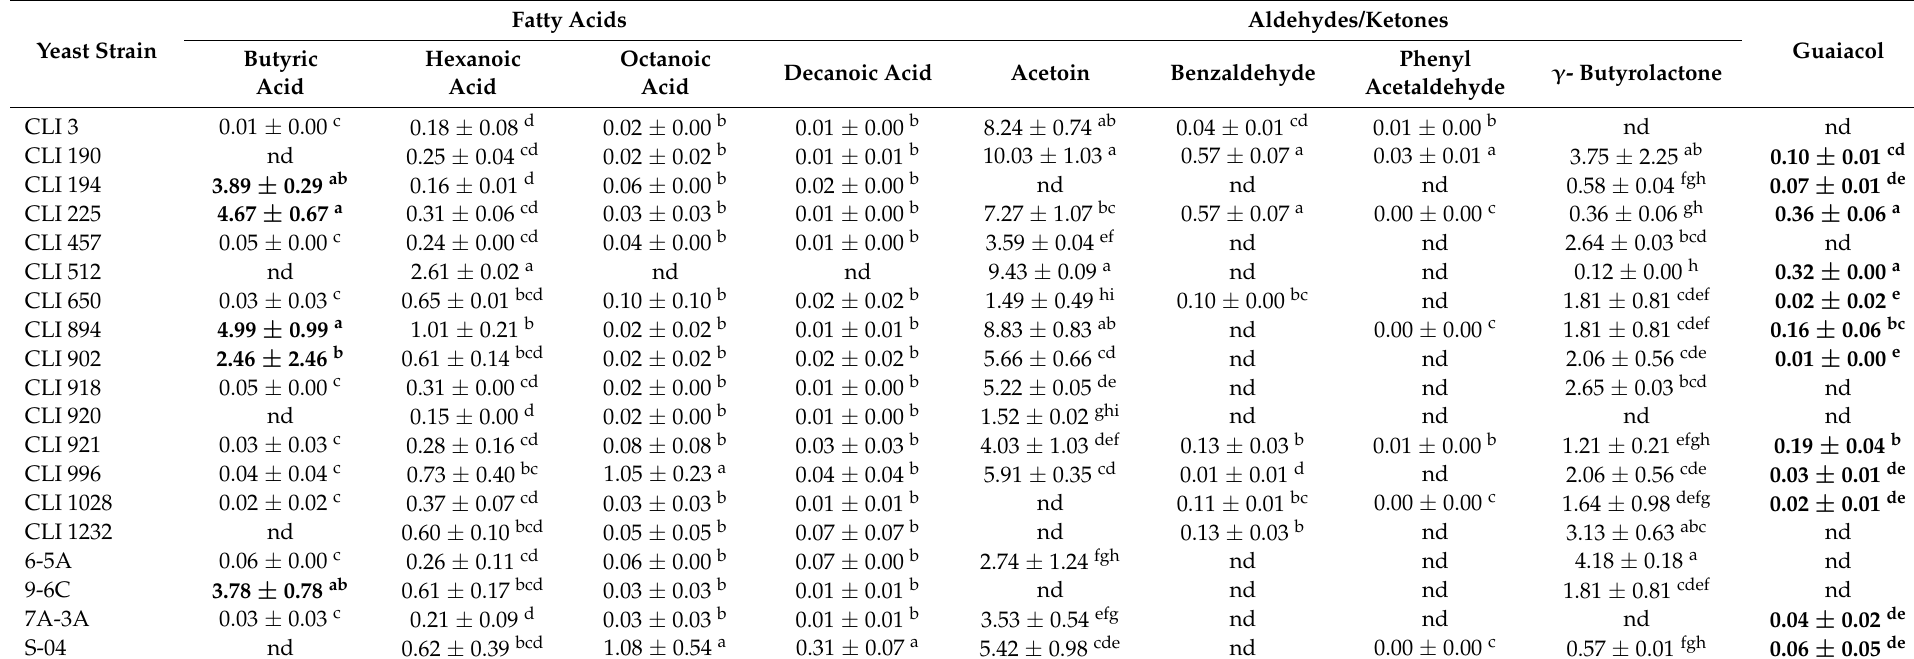
Table 4. The main volatile compounds (fatty acids, aldehydes/ketones and guaiacol) in the green beer produced by the different yeast strains.